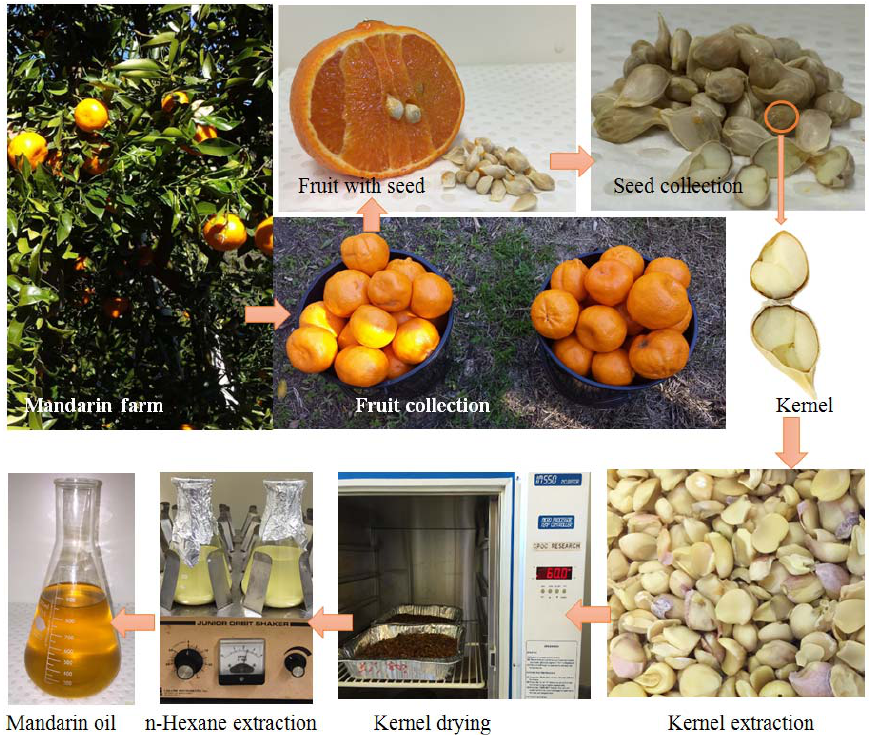
Figure 2. Oil extraction from mandarin seed by n ‐ hexane method. Table 2. Summary of observations on random samples of Australian mandarin fruit.